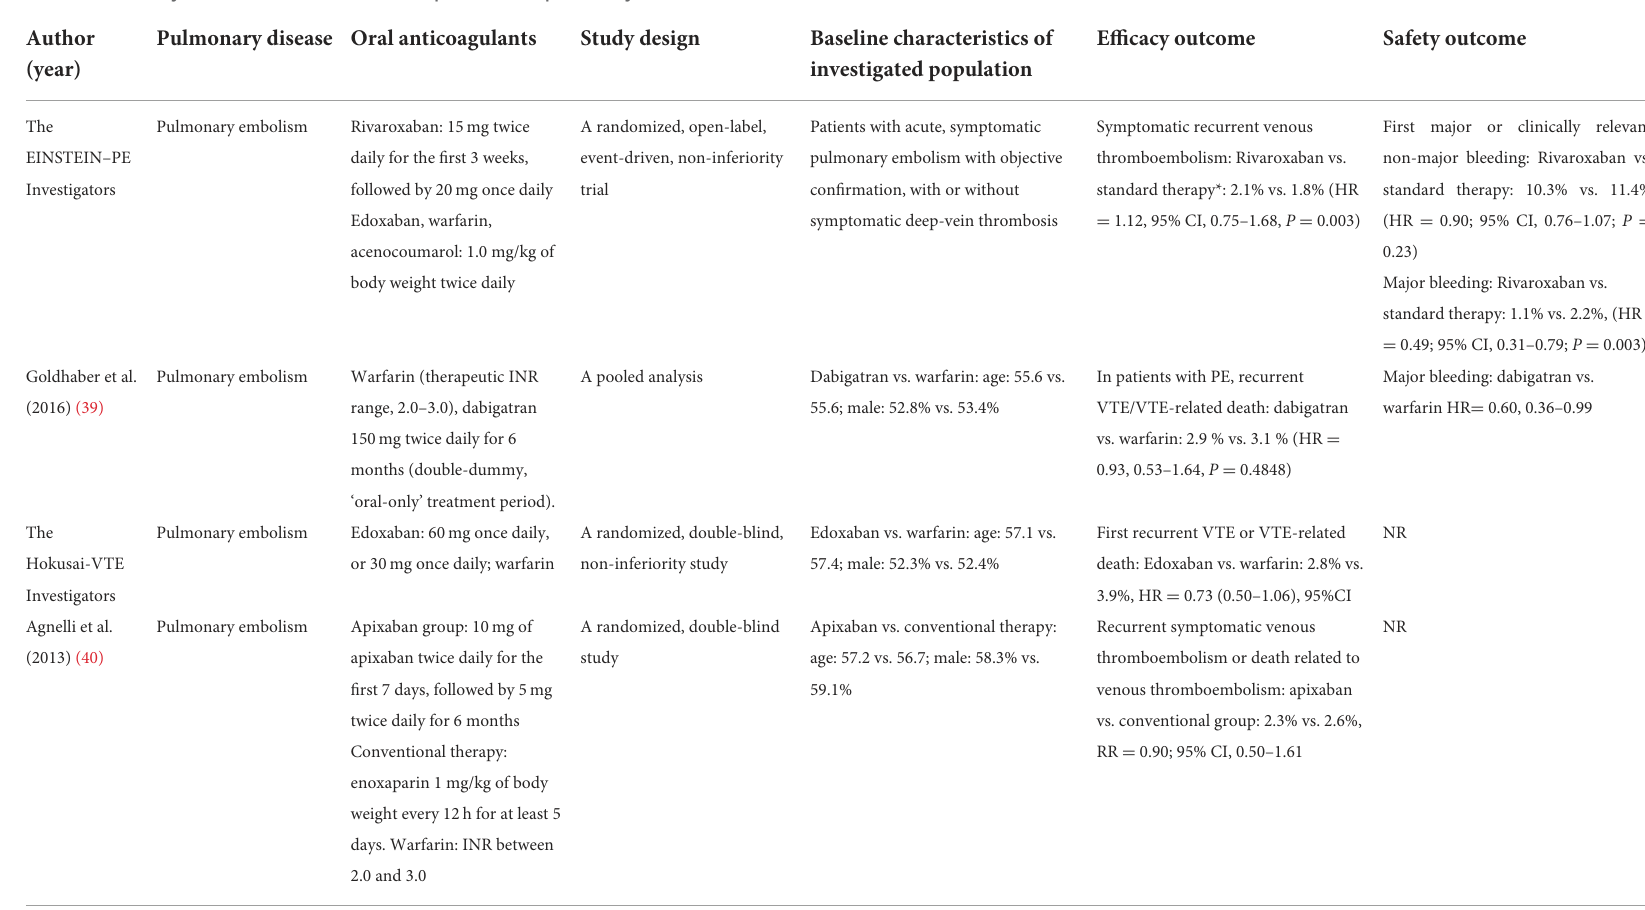
TABLE 2 Summary of included studies of OACs in patients with pulmonary